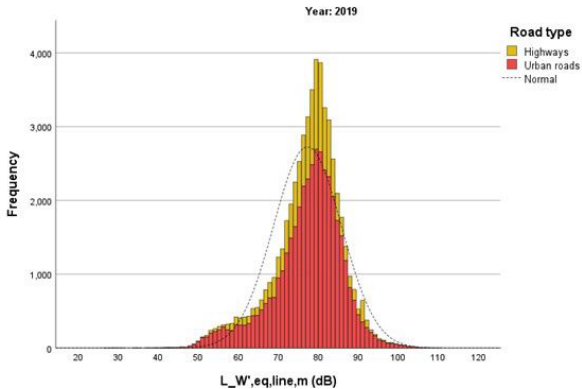
Figure 1: Distributions of the directional sound power per meter values for 2019 simulation; bars stacked by road type